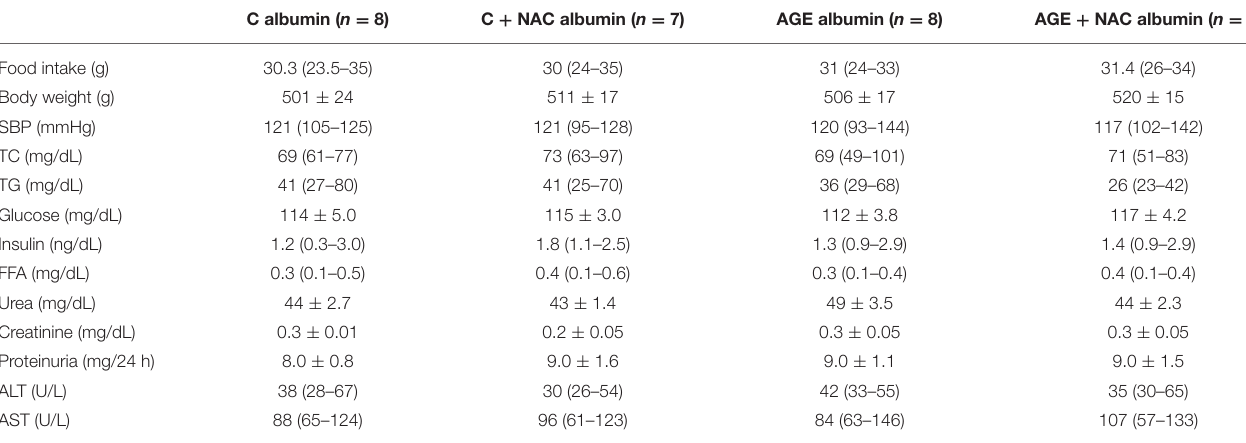
TABLE 1 | Biochemical parameters of animals treated with C or AGE-albumin, concomitantly or not NAC, at the end of protocol.